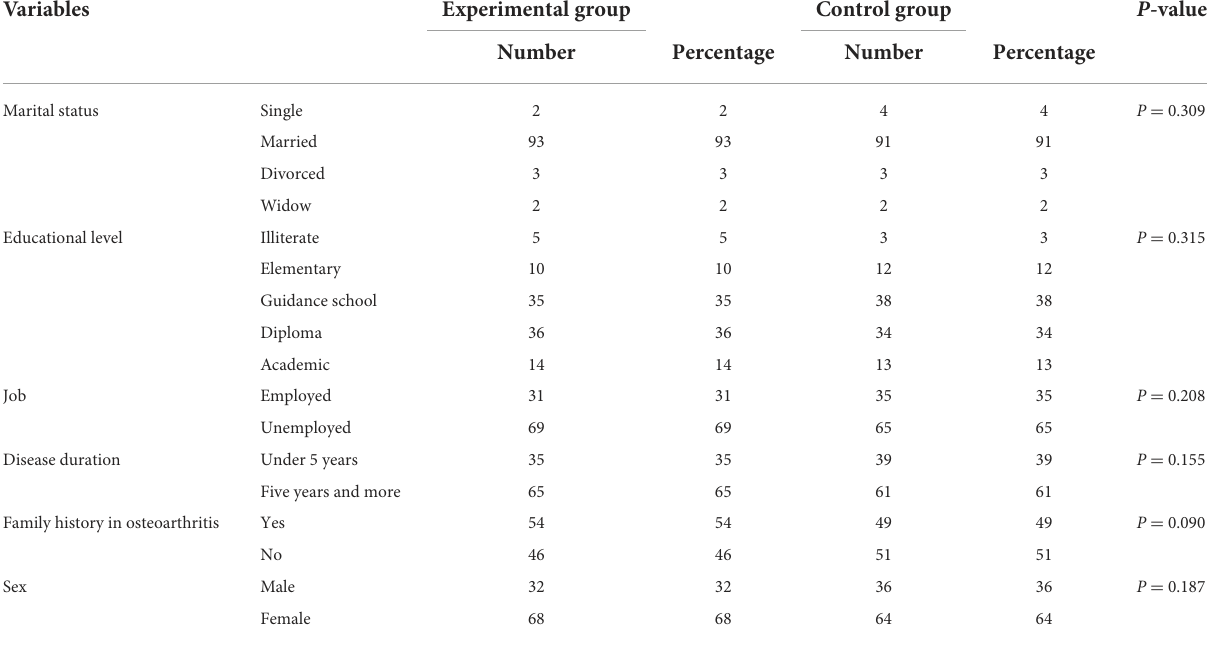
TABLE 2 Frequency distribution of studied subjects based on their personal